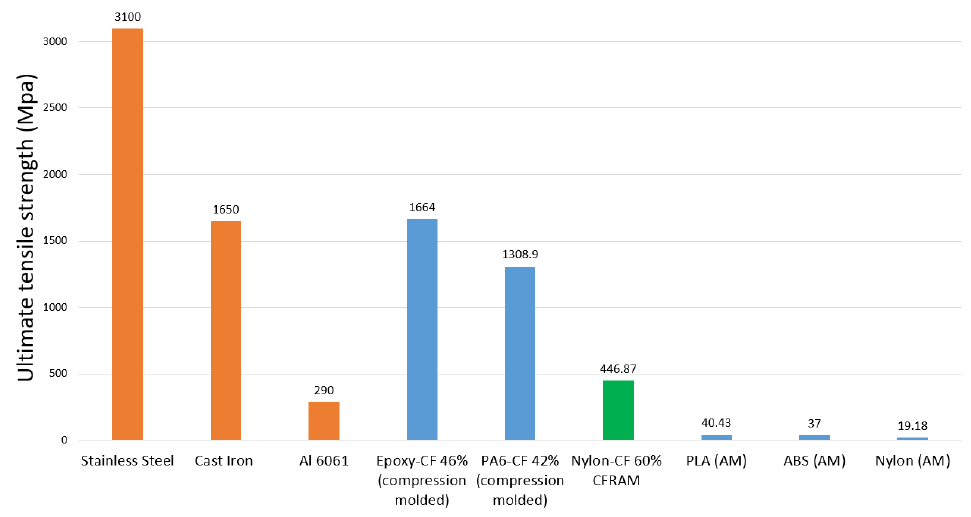
Figure 12. Comparison of ultimate tensile strength of conventional materials used in manufacturing.